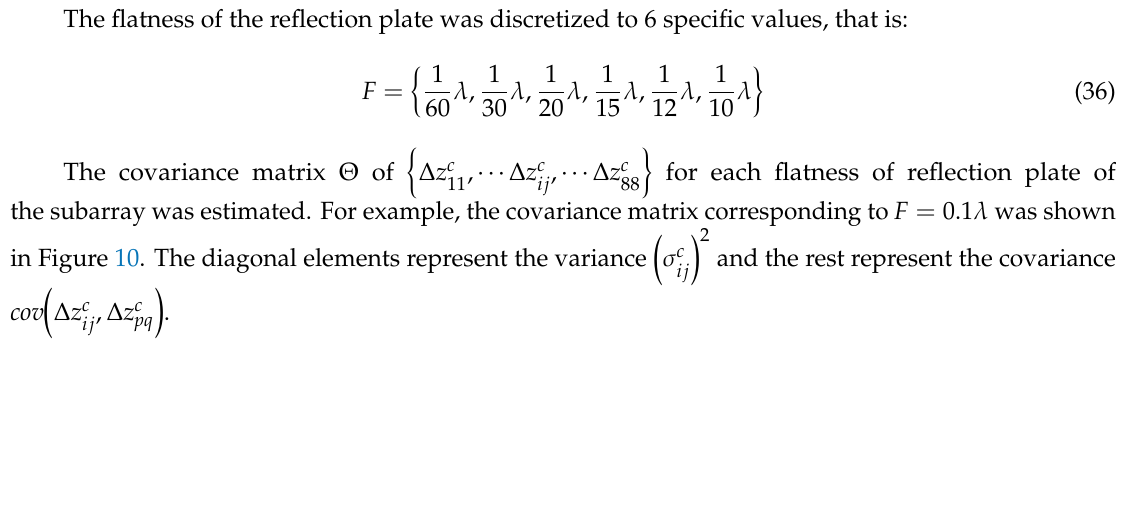
Figure 10. The covariance matrix 𝛩 of the reflection plate of the subarray ( F = 3 mm). Obviously, the values of the diagonal elements of the covariance matrix are much bigger than those of the rest, which indicates the correlation between continuous errors of adjacent assembly holes on the reflection plate. For example: